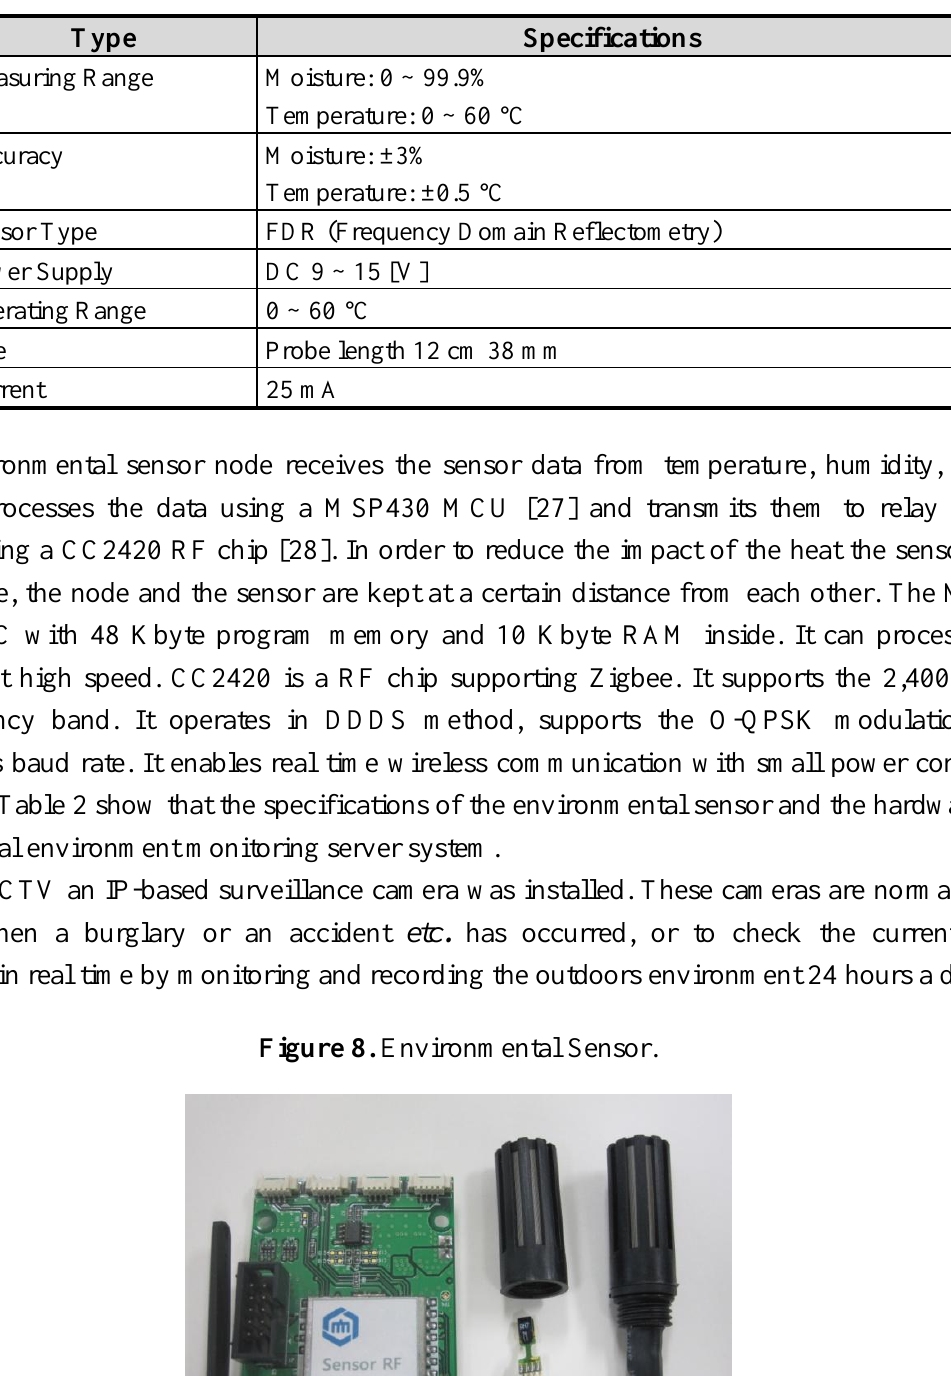
Table 1. Hardware Specifications of the Soil Sensor.